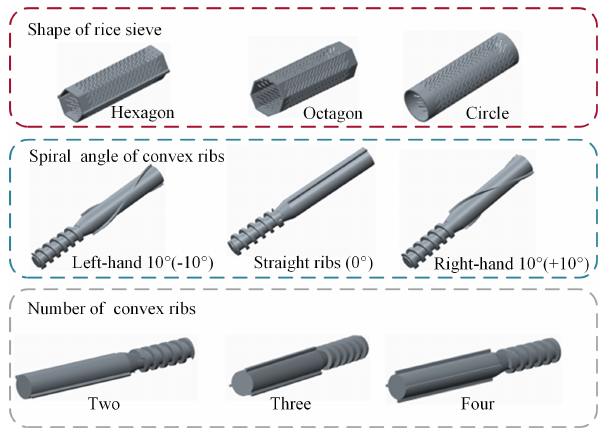
Figure 5. Different geometries of a milling chamber.